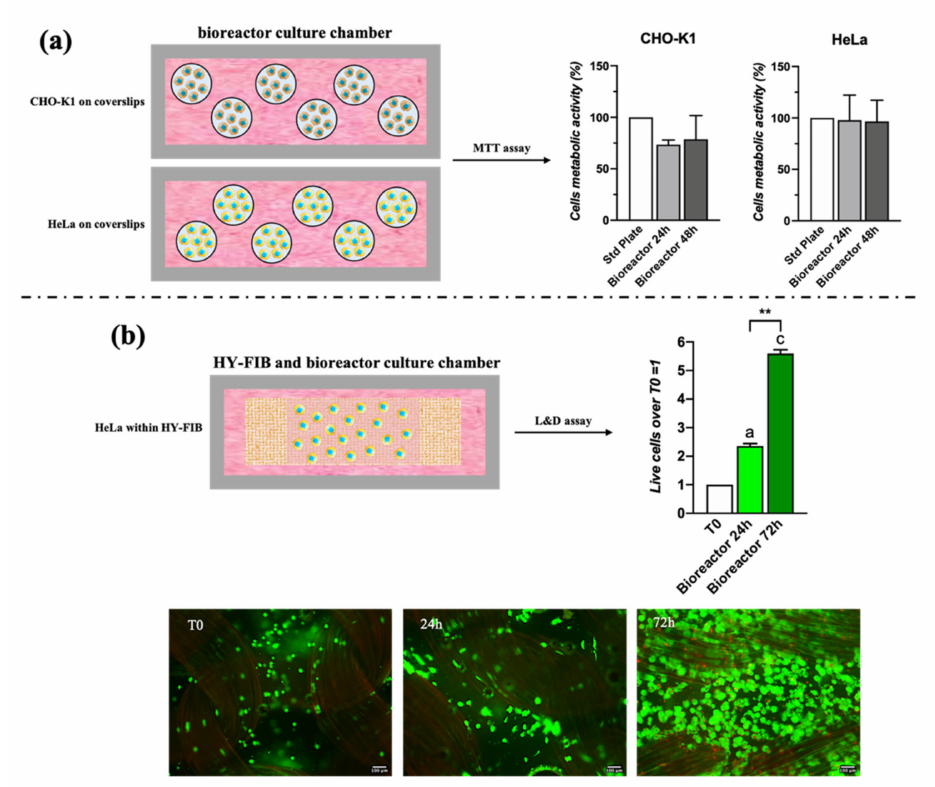
Figure 1. Cytotoxicity assay of 3D printed cyclic strain bioreactor with CHO-K1 and HeLa cells. MTT assay on CHO-K1 and HeLa cells seeded on coverslips at 24 h and 48 h of culture in the bioreactor chamber. The histograms report the mean percentage of viable cells compared to control (cells cultured in a standard plate, 100%) ( a ). Live and Dead assay at 24 h and 72 h on HeLa cells embedded in the 3D fibrin hydrogel of the 3D scaffold. The green signal, indicating viable cells, was quantified using ImageJ software and presented as fold change over T0 = 1 ( b ). Statistically significant differences are shown as ** = p ≤ 0.01 compared to T0. Scale bar = 100 µ m.